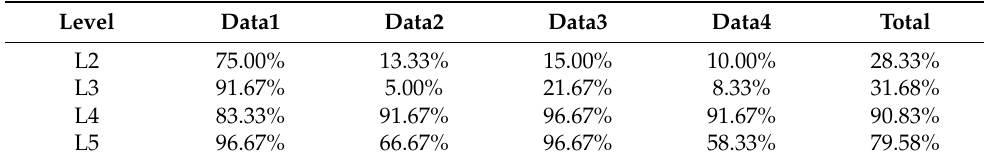
Table 1. The classification results of different